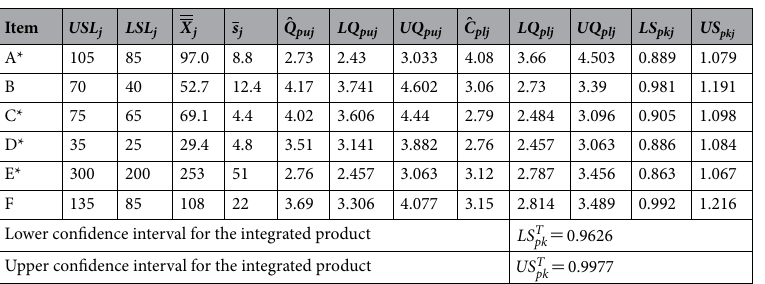
Table 2. The analytical results of a driver IC